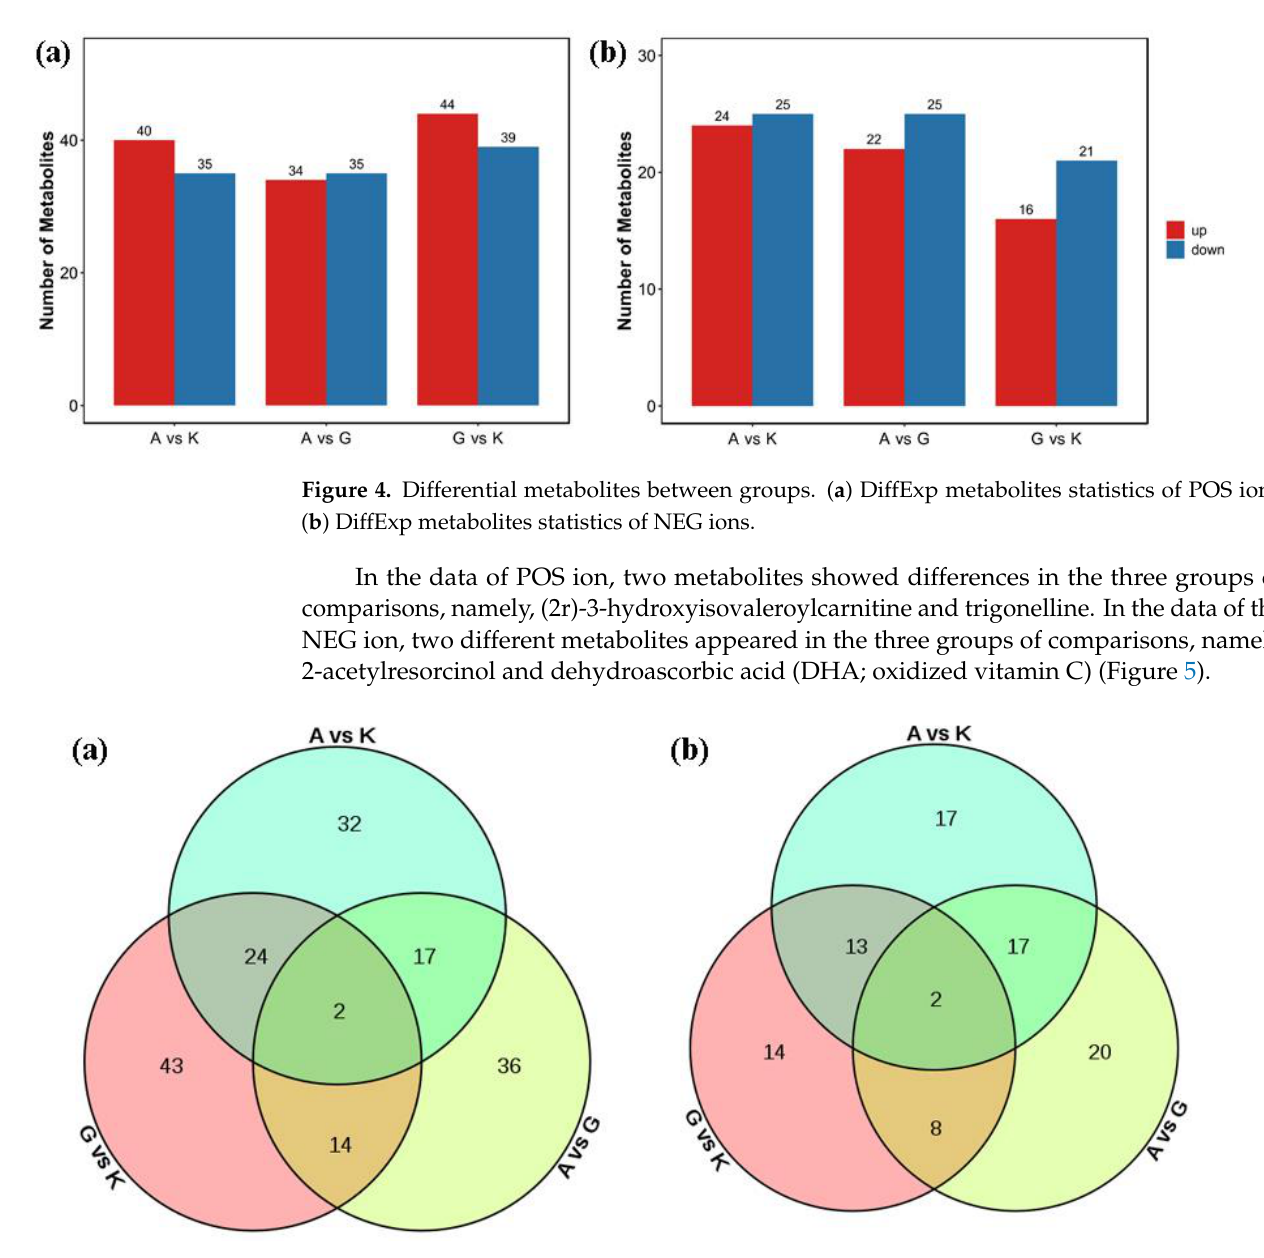
Figure 5. Venn diagram of differential metabolites comparing the three groups. (a) Comparing through POS ions; (b) Comparing through NEG ions.